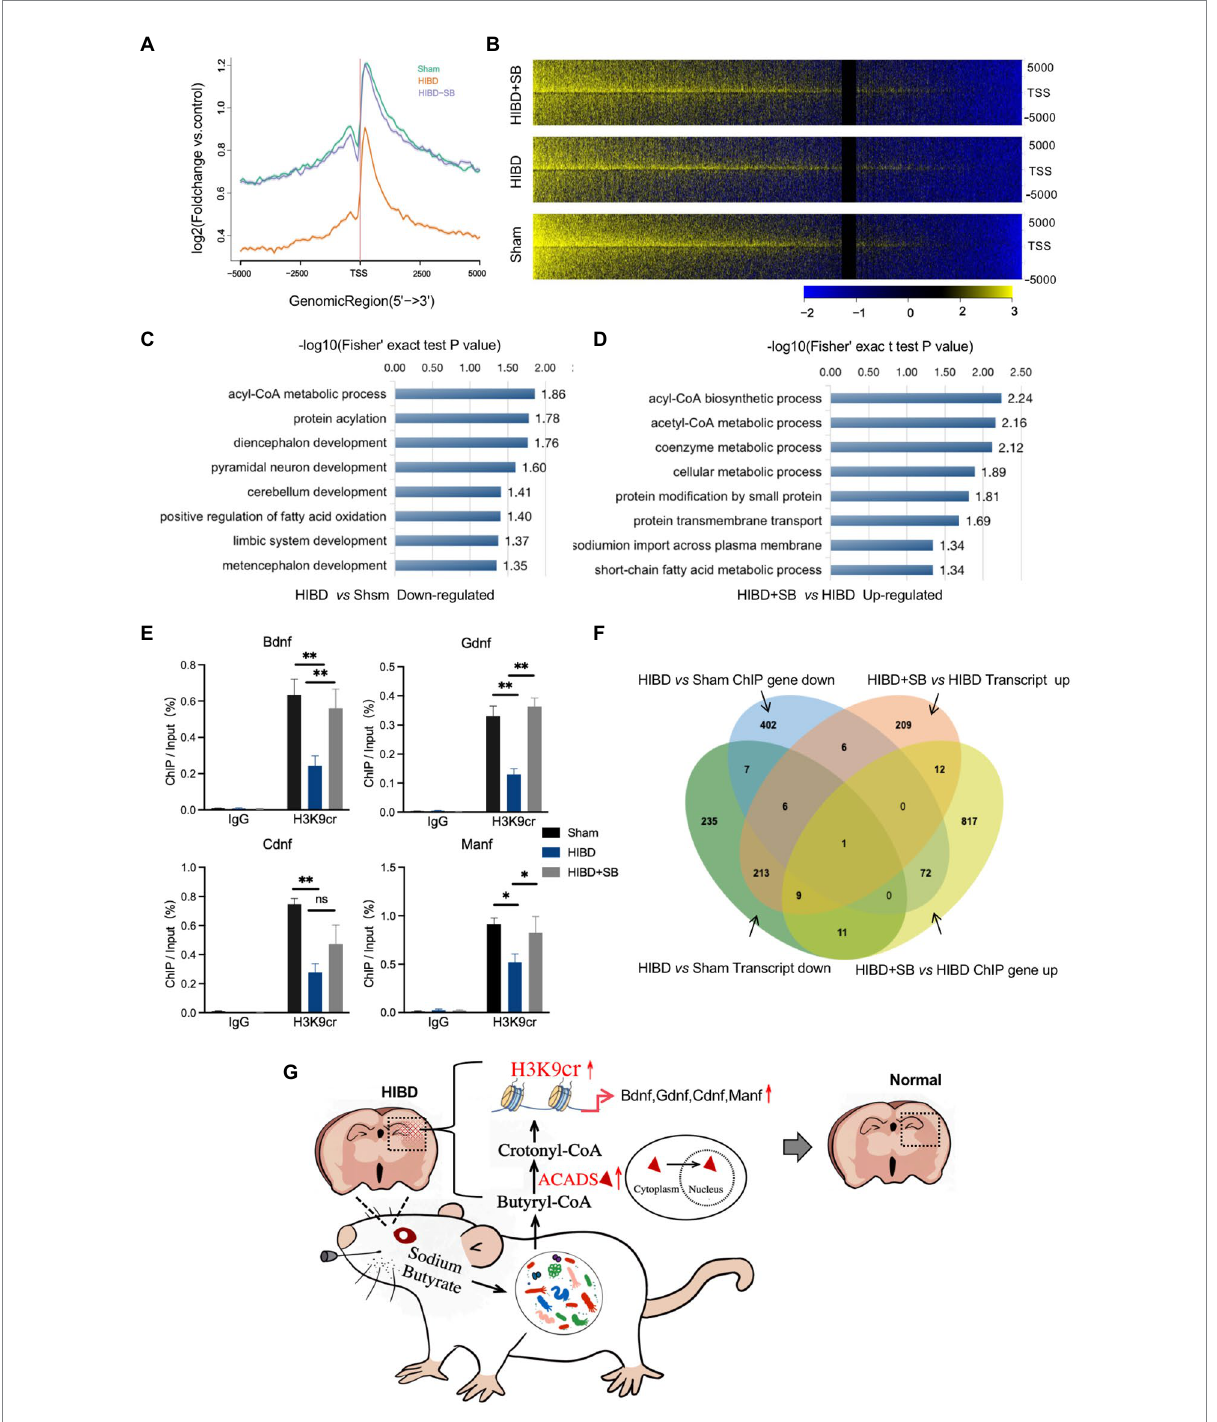
FIGURE 8 ( A ) Comparison of average ChIP-Seq peaks aggregated around TSS for H3K9cr between Sham, HIBD and HIBD + SB group rats. ( B ) ChIP-Seq enrichment profiles for H3K9cr levels in Sham, HIBD and HIBD + SB group rats. ( C ) Genes corresponding to differential enrichment peaks in the promoter region (TSS − 2000 to TSS + 2000) were used to GO analyze. The bar chart shows the significantly down-regulated GO terms and their adjusted p -values in the HIBD compared with Sham group. ( D ) The bar chart shows the significantly up-regulated GO terms and their adjusted p -values in the HIBD + SB compared with HIBD. ( E ) Enrichment of HIE-related neurotrophic factor genes Bdnf , Gdnf , Cdnf and Manf was measured by CHIP-qPCR. IgG was used as control, n = 3, * p < 0.05, ** p < 0.01, error bars represent SD. ( F ) Venn diagram of ChIP seq and RNA seq combined analysis. ( G ) After SB intragastric treatment, the gut microbiota composition and the fecal metabolic phenotype in neonatal HIBD rats were significantly changed. SB is absorbed by gut microbiota and metabolized primarily as butanoyl-CoA, and further converted to crotonyl-CoA by ACADS in the nucleus. These molecular metabolites ultimately alleviate brain injury by specifically regulating the H3K9cr enrichment level and binding genes Bdnf , Gdnf , Cdnf , and